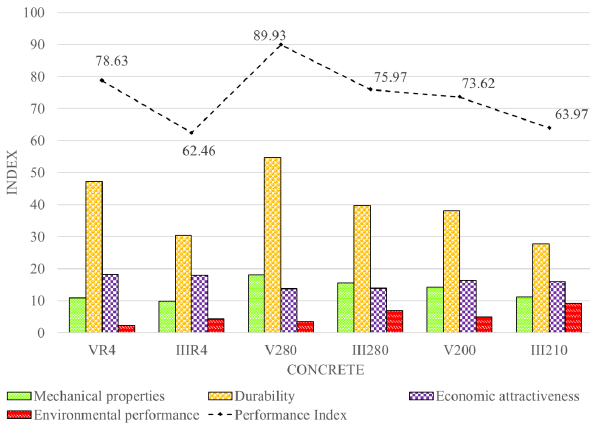
Figure 3. Partial indices of criteria and final performance index - Scenario 1 (industrial floor).